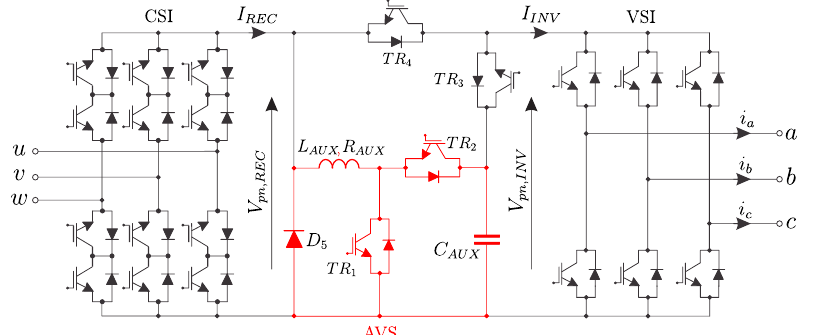
Figure 27. Hybrid indirect matrix